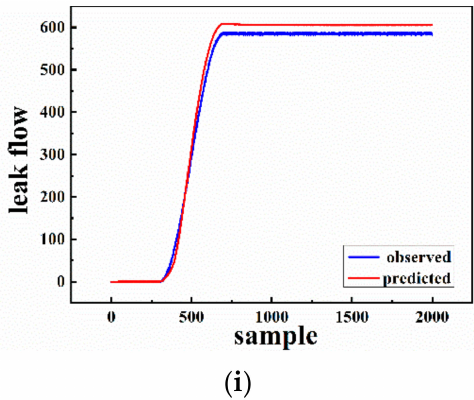
Figure 9. Comparison of prediction results with real data under different schemes ( a – i ).